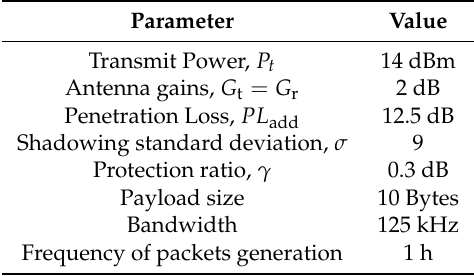
Table 1. Simulation Parameters.